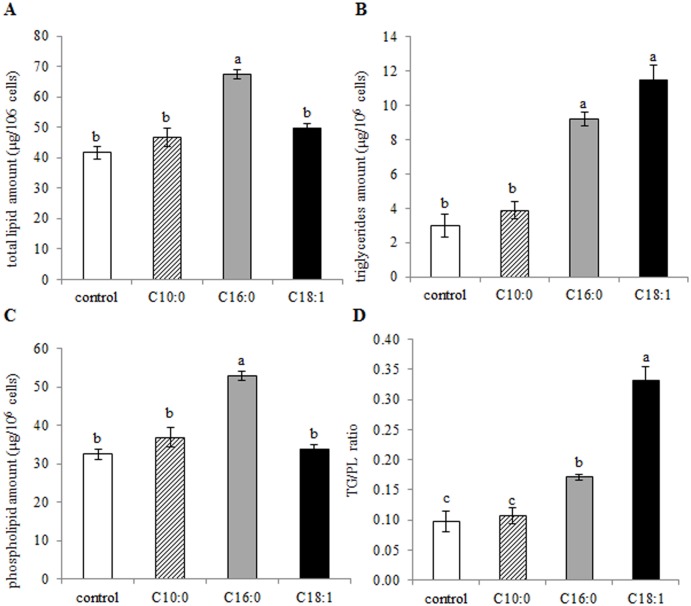
Specific free fatty acids (FFAs) influence amounts and ratio between polar and neutral lipids in mammary epithelial cells.Mammary epithelial cells were treated with 100 μM FFA (capric, palmitic or oleic acid) or with FFA-free medium (control) for 24 h; lipids were then extracted and analyzed by HPLC-ELSD. (A) Total lipid amount. (B) Triglyceride amount. (C) Total phospholipid amount. (D) Triglyceride-to-phospholipid ratio. All data are presented as mean ± SEM. Different letters indicate significant differences between treatment groups (P < 0.05).